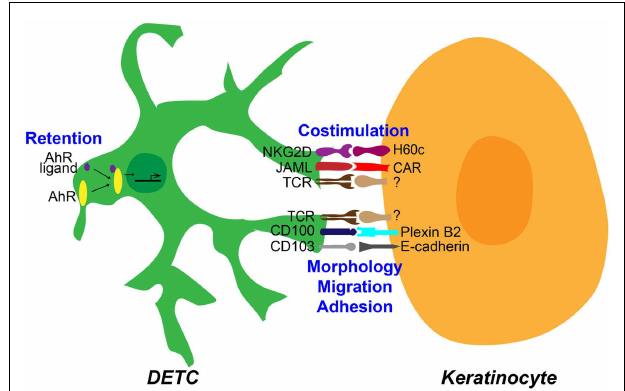
FIGURE 1 | Epithelial γδ T cell interactions with keratinocytes in the epidermis . Distinct functional interactions occur between dendritic epidermalT cells (DETC) and neighboring keratinocytes in the epidermis of murine skin. DETC respond to an unknownT cell receptor (TCR) ligand expressed by keratinocytes.This response is concomitant with interactions regulating costimulation, morphology, migration, and adhesion, as well as likely through interactions that mediate retention of DETC in the epidermis. All these interactions are required for efficient DETC activation and effector